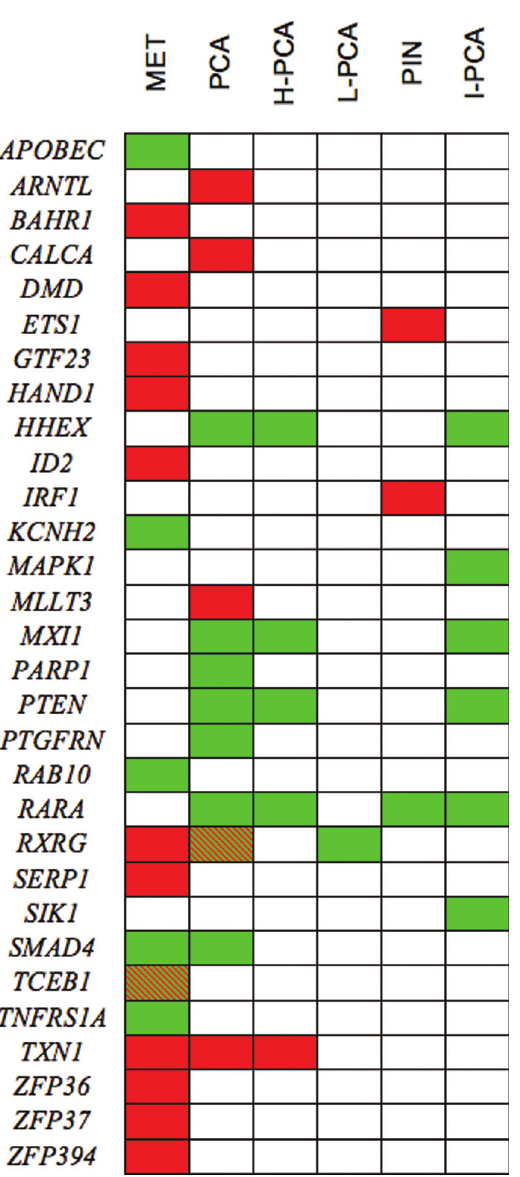
(Figure 3). Associations were found with metastatic cancer (12/6; gains/losses), localized high (1/4; gain/losses) and low risk (1 loss; RXRG ), prostate intraepithelial neoplasia (PIN) (2/1; gains/loss) (Kim et al. , 2007), and with the in- termediate risk prostate cancer (6 losses) (Ishkanian et al. , 2009). Remarkably, ETS1 and IRF1 appeared in regions of gains in PIN but not in other disease states, and MAPK1 and SIK1 were located in (or nearby) regions deleted in in- termediate-risk cancer.